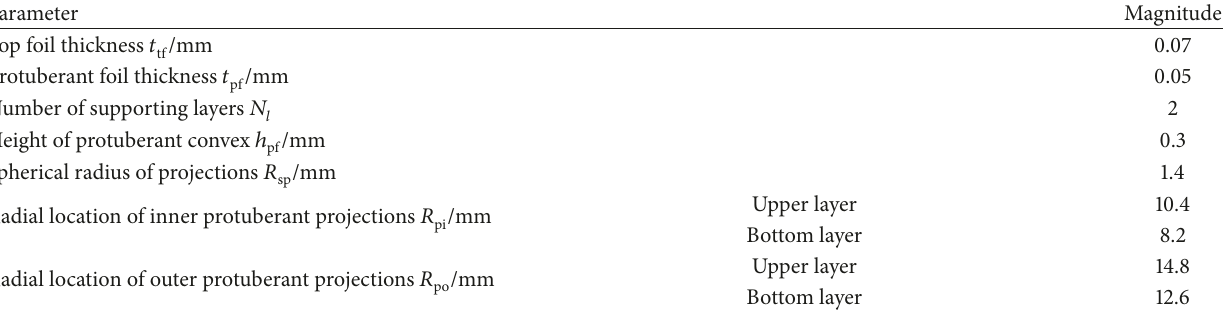
Table 4: Geometrical parameters of the protuberant foil thrust bearing